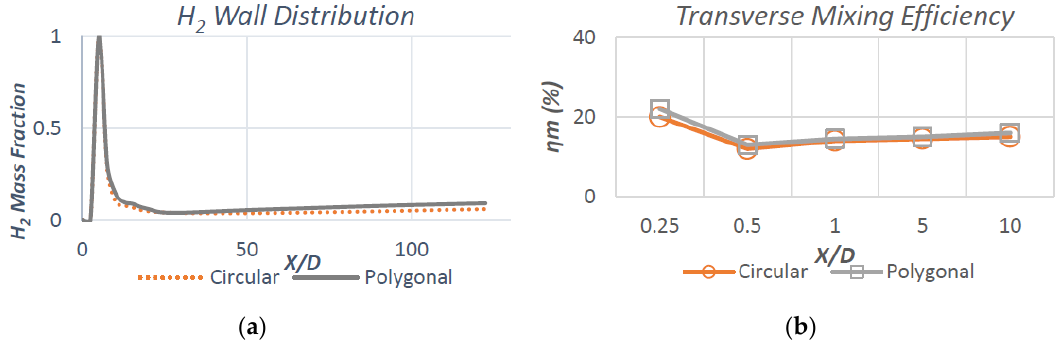
Figure 16. ( a ) H 2 wall distribution; ( b ) Transverse mixing efficiency. Elliptical vs. polygonal injectors.